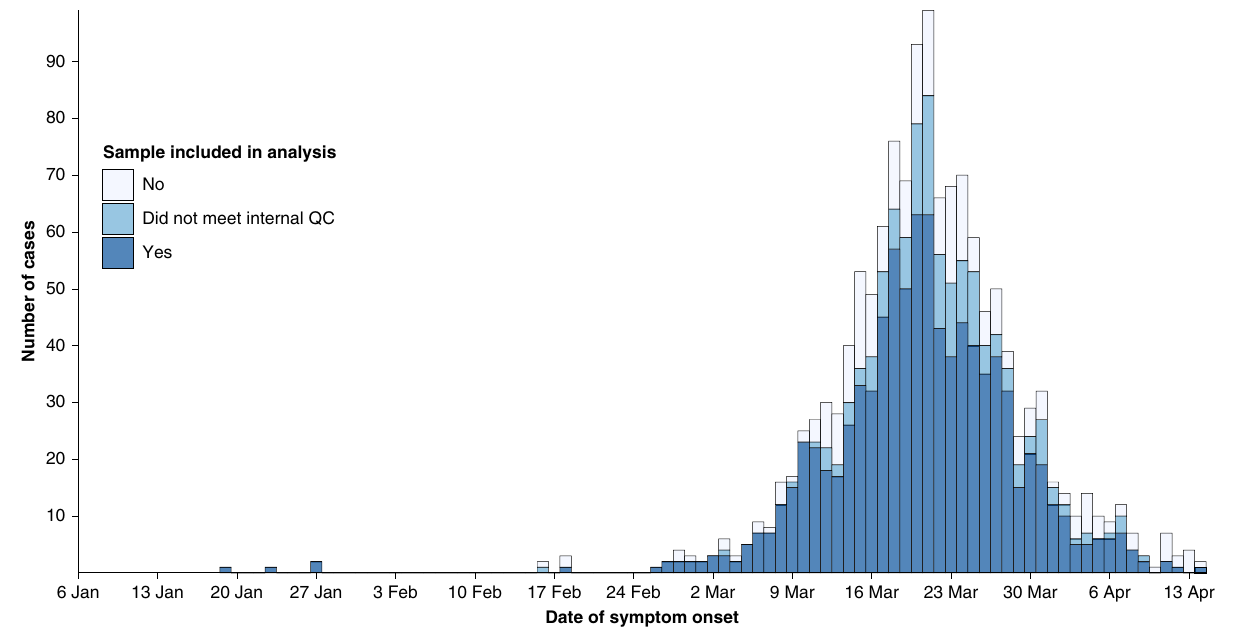
Fig. 2 Samples included in genomic analysis. Epidemic curve of sequenced patient samples by date of symptom onset, colored by the outcome of sequencing after quality control (QC) procedures applied. Dark blue represents successful sequencing meeting QC parameters; white represents failed sequencing; light blue represents sequences with severe acute respiratory syndrome coronavirus 2 (SARS-CoV-2) reads that did not meet internal QC parameters, but may still yield useful phylogenetic data for